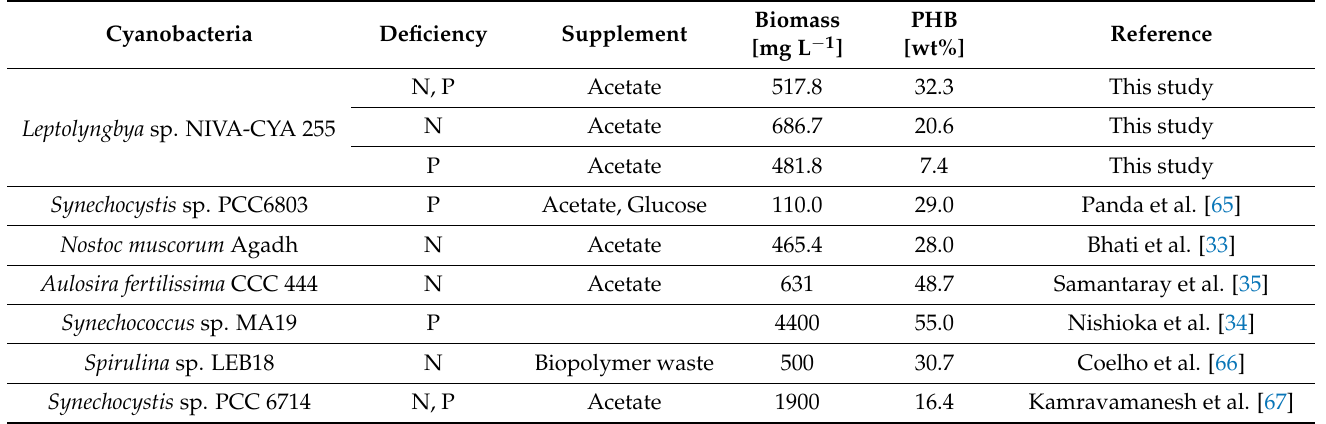
Table 2. Production of PHB by cyanobacteria under conditions similar those in this